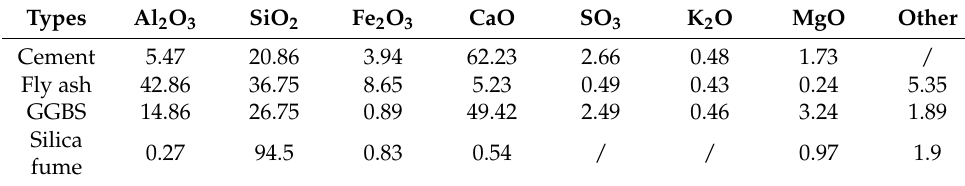
Table 1. Chemical composition and content of fly ash and slag powder